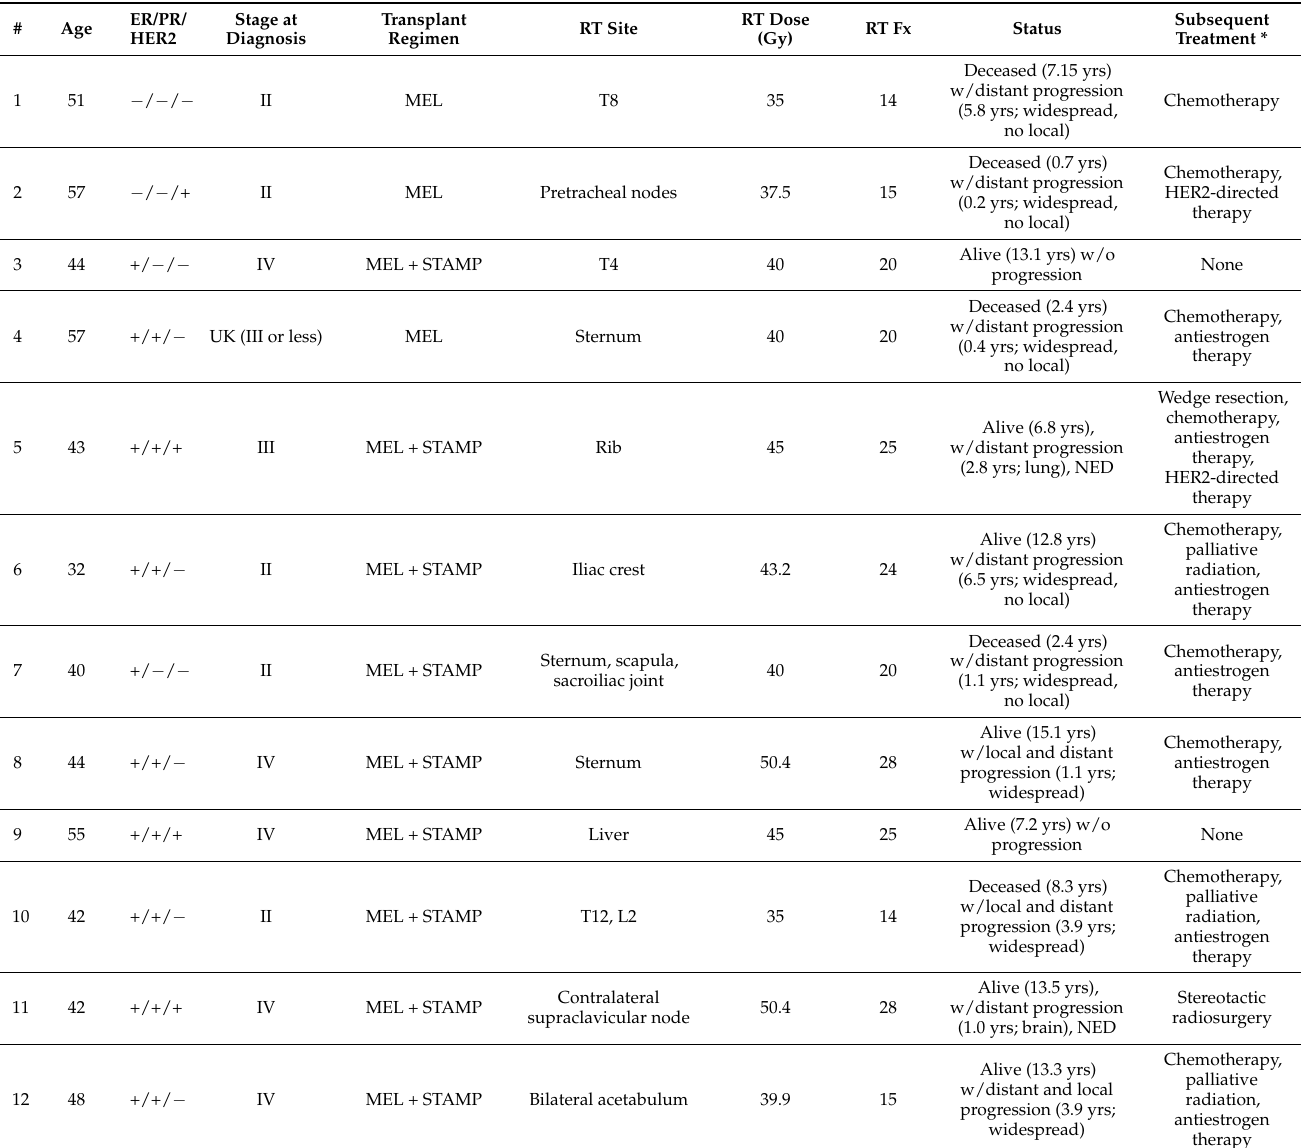
Table 2. Individual patient